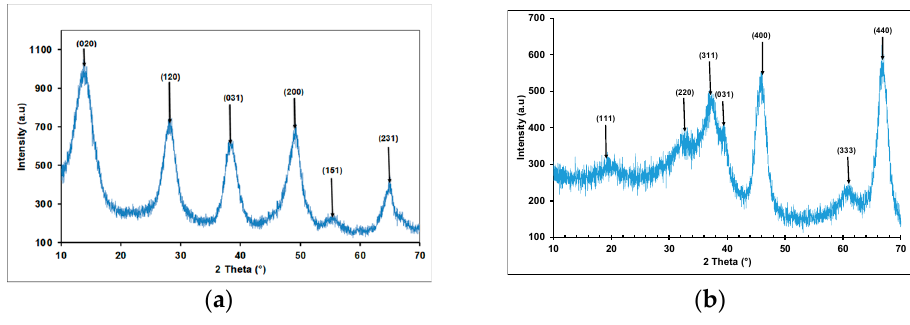
Figure 3. ( a ) X-ray diffraction of boehmite; ( b ) X-ray of γ ANPs.